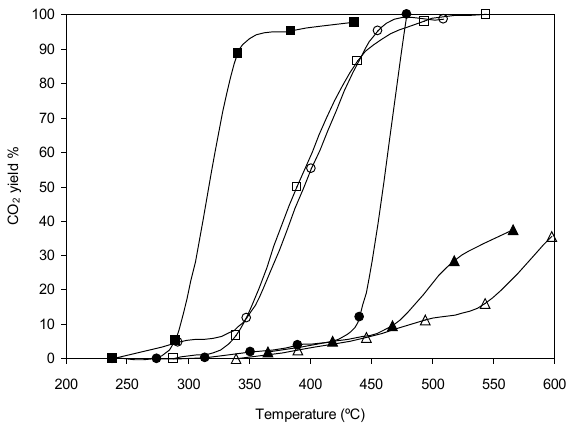
Figure 3: Propane combustion vs. temperature for: ∆) CoCli, ▲ ) CoCli-Mor, □) RhCli, ■) RhCli-Mor, ○) RhCoCli, ●) RhCoCli-Mor. Reaction conditions: catalyst 0.100 g, total flow 50 mL min -1 , 2000 ppm of C H , 8% of O and He to balance. 3 8 2